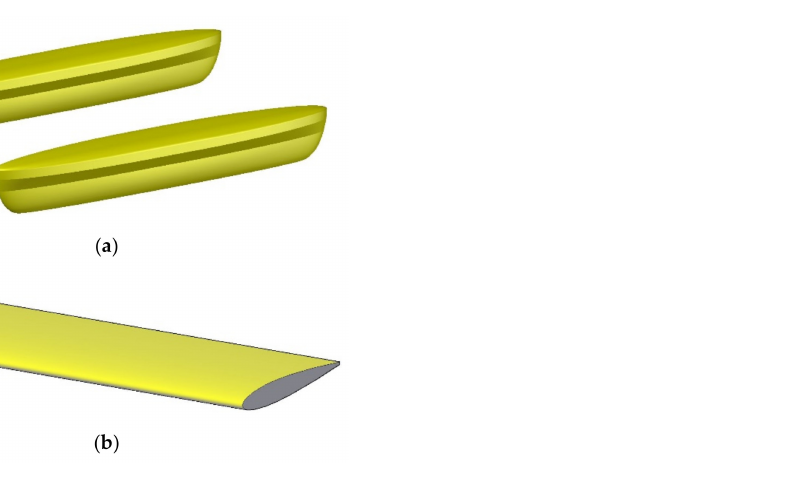
Figure 2. Simplified three-dimensional model of wave-driven catamaran. ( a ) Two demihulls of catamaran. ( b ) Oscillating hydrofoil.